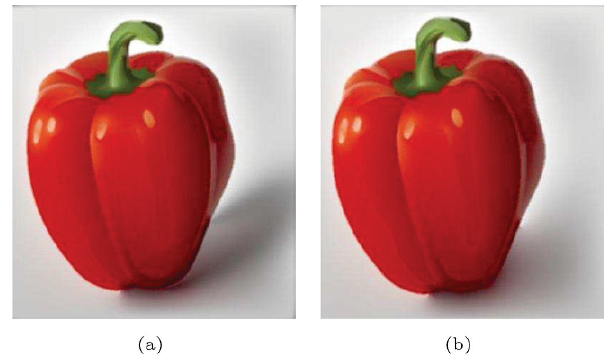
Fig. 10 Direction coefficient layers in the DCC model can be employed to generate shadows, which is not easy to do using the classical Poisson model [1]. (a) Pepper image with shadows generated by the DCC model. (b) Image produced by the classical Poisson model, using the same color sources as in (a). Note lack of a clear shadow in (b).